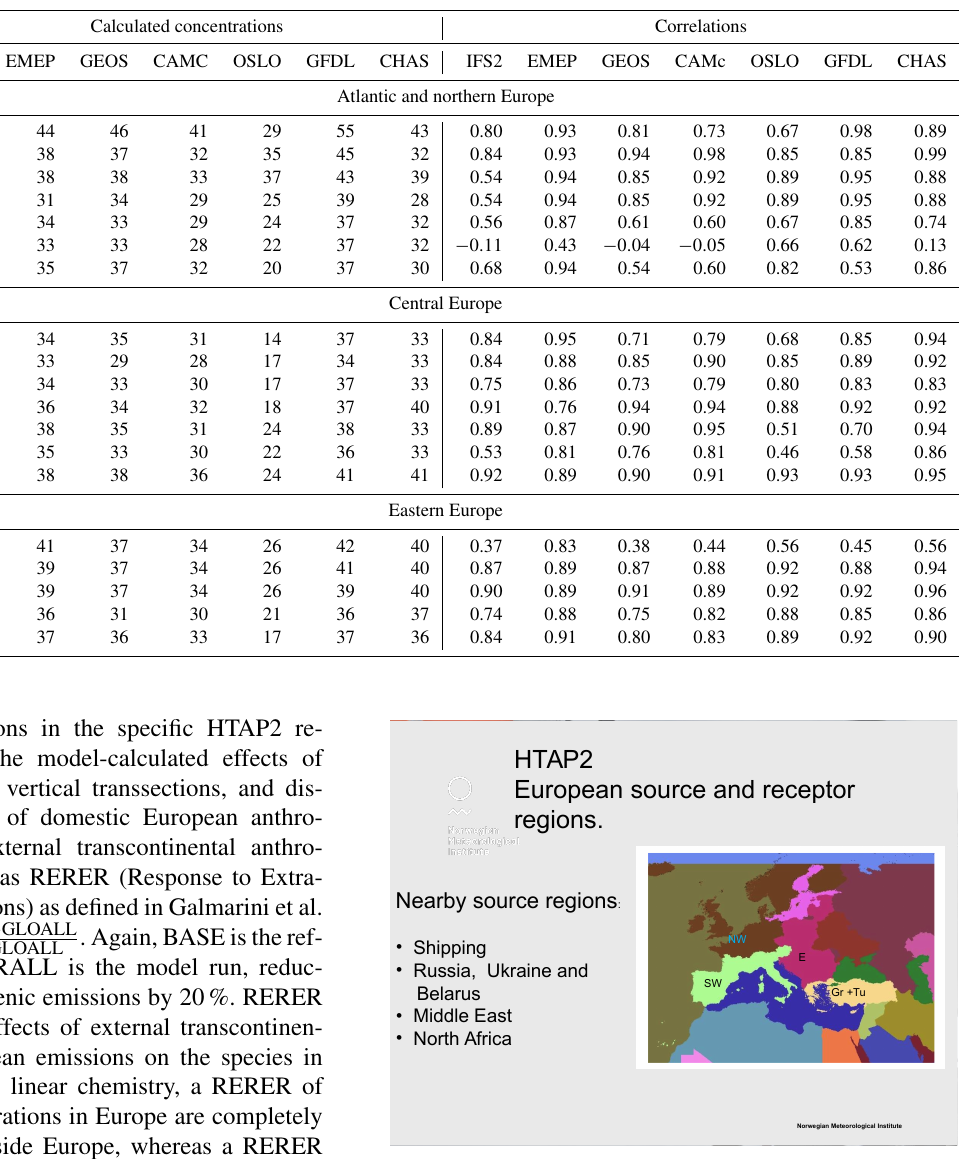
Figure 1. HTAP2 regions. The European land areas are further sub- divided: NW is western Europe, north of the Alps; SW is western Europe south of the Alps; E is eastern Europe and Gr + Tu is Greece and